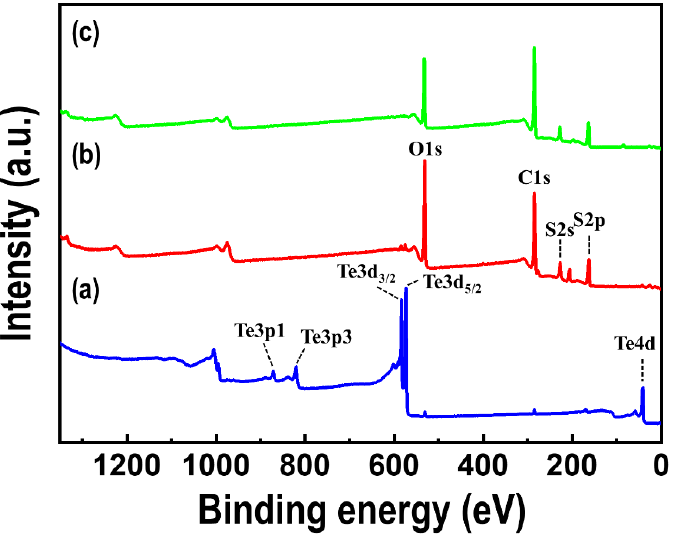
Figure 7. X-ray photoelectron spectroscopy (XPS) spectra of ( a ) Te nanorod array, ( b ) PEDOT/Te composite film with polymerization time of 15 s, and ( c ) PEDOT film.